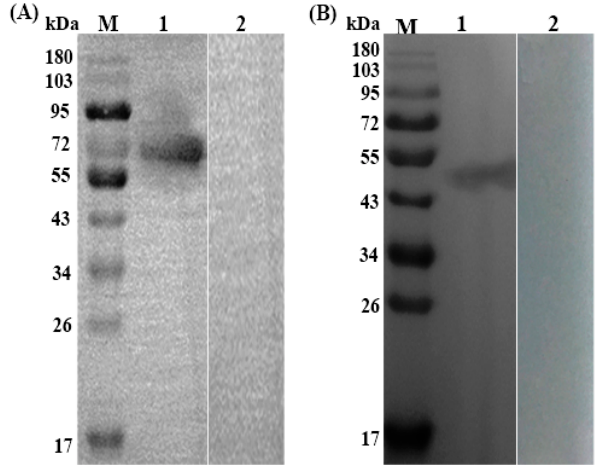
Figure 2. Western blot analysis. Lane M: standard protein molecular weight marker. ( A ) Western blot analysis of rTs-SUCLA - β . Lane 1: serum sample from T. spiralis experimentally infected mice; Lane 2: serum sample from normal mice; ( B ) Western blot analysis of ML protein. Lane 1: serum sample from SD rats containing polyclonal antibodies against rTs-SUCLA- β ; Lane 2: serum sample from normal SD rats.